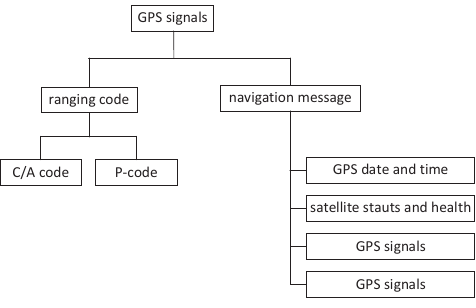
Figure 4. GPS signal structure.